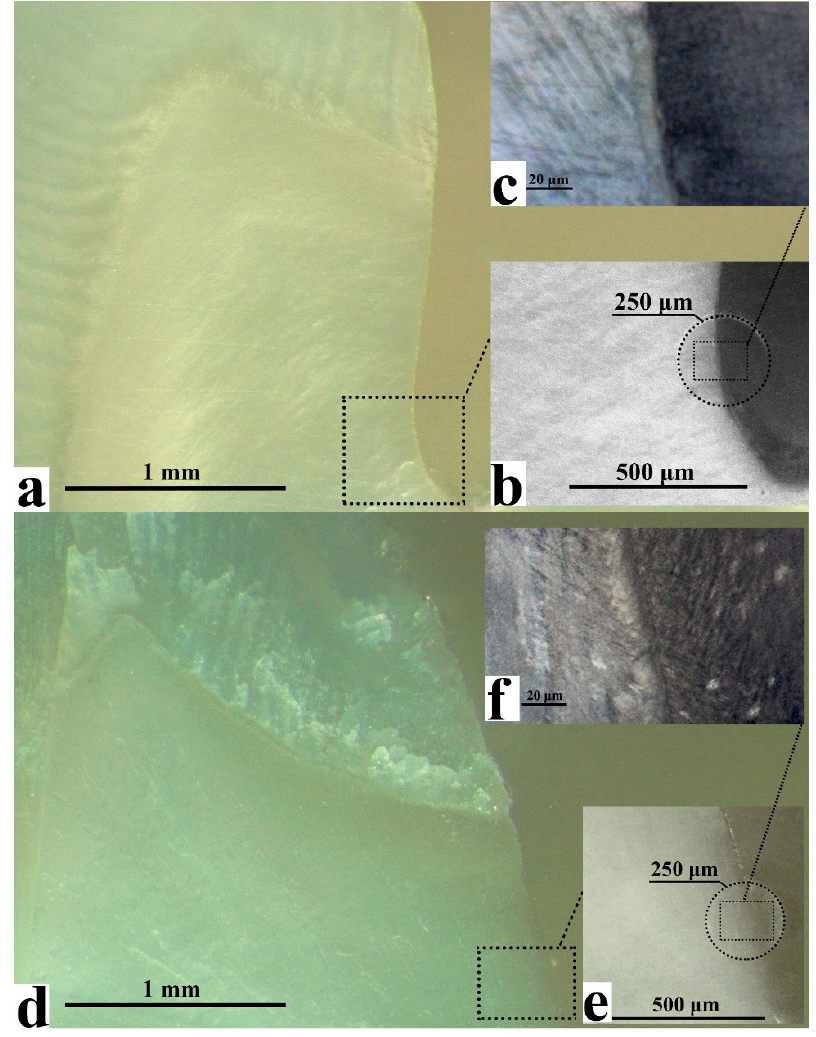
Figure 1. Representative optical images of interface areas for type I ( a – c ) and type II- biomimetic ( d – f ) samples at different magnifications.